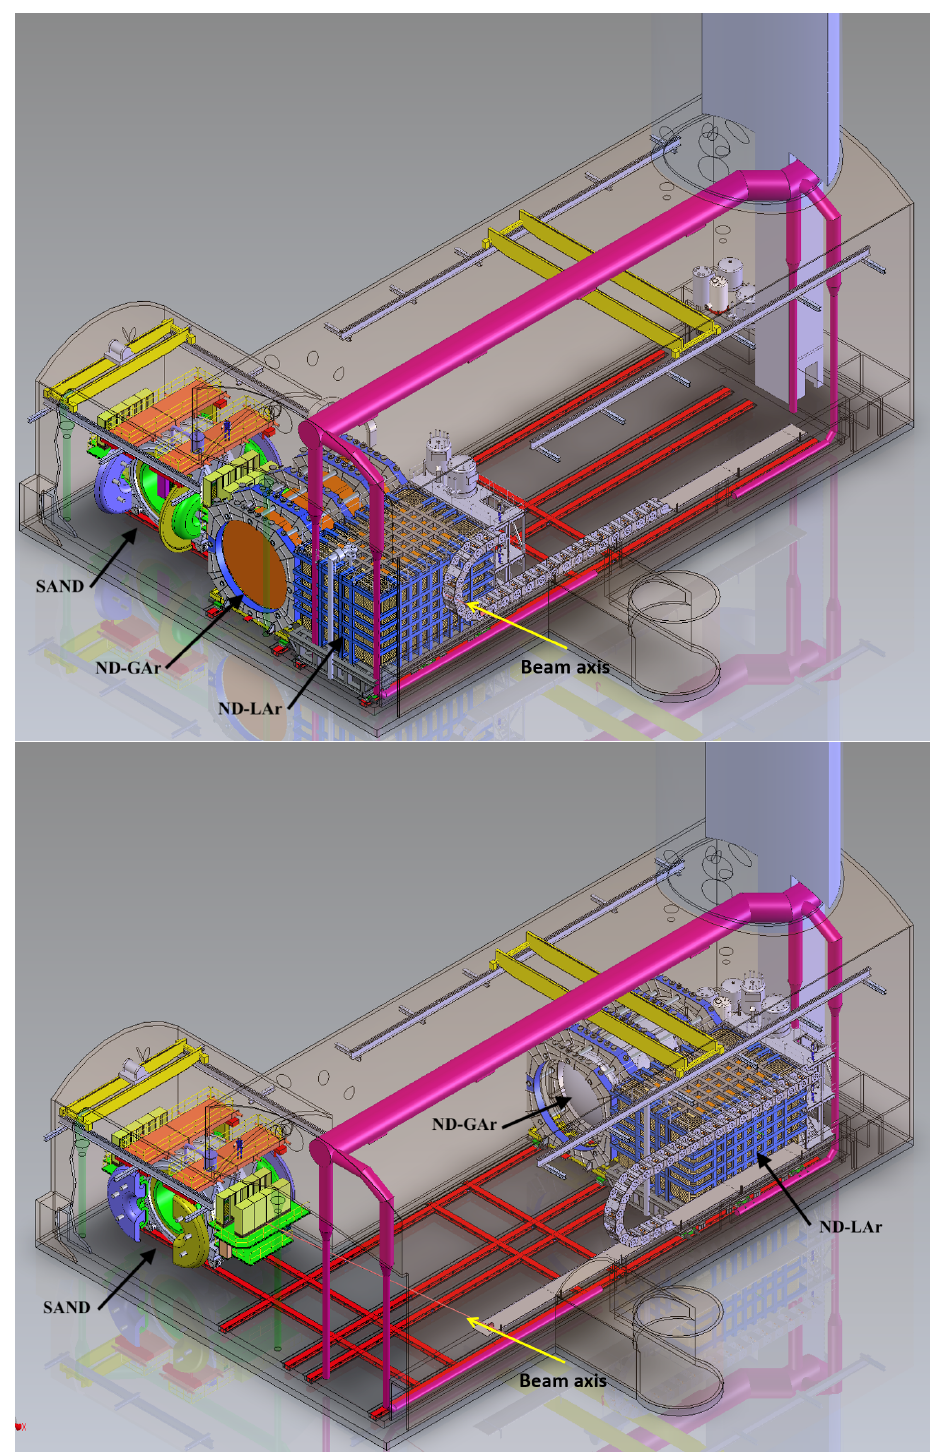
Figure 1. Schematic of the DUNE ND hall shown with component detectors all in the on-axis configuration ( top ) and with the ND-LAr and ND-GAr in an off-axis configuration ( bottom ). The SAND detector is shown in position on the beam axis. The beam axis and direction are indicated. The person on top of ND-LAr gives an indication of